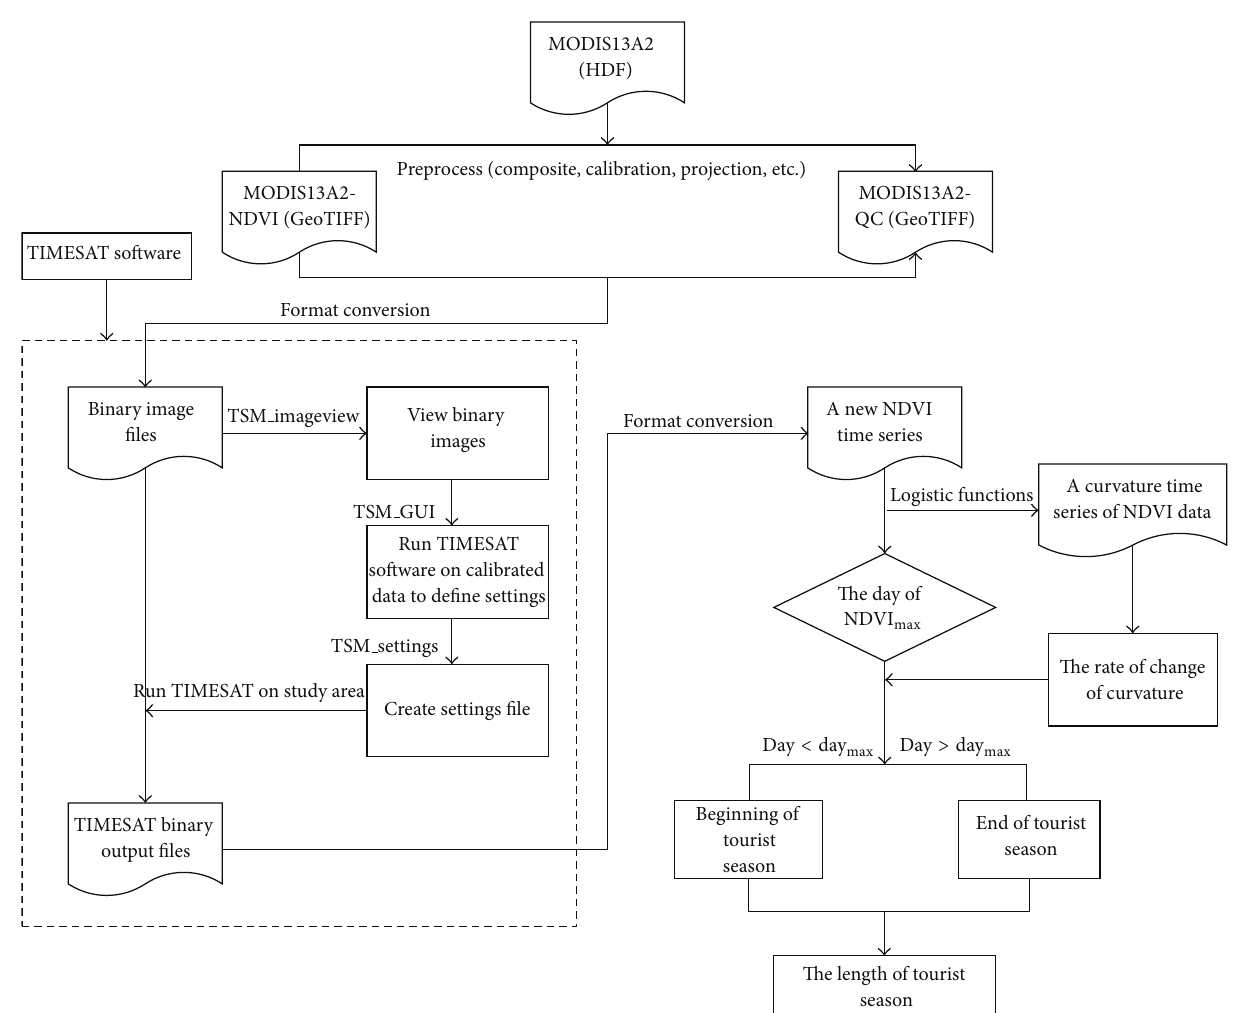
Figure 3: Flowchart of grassland tourist season monitoring